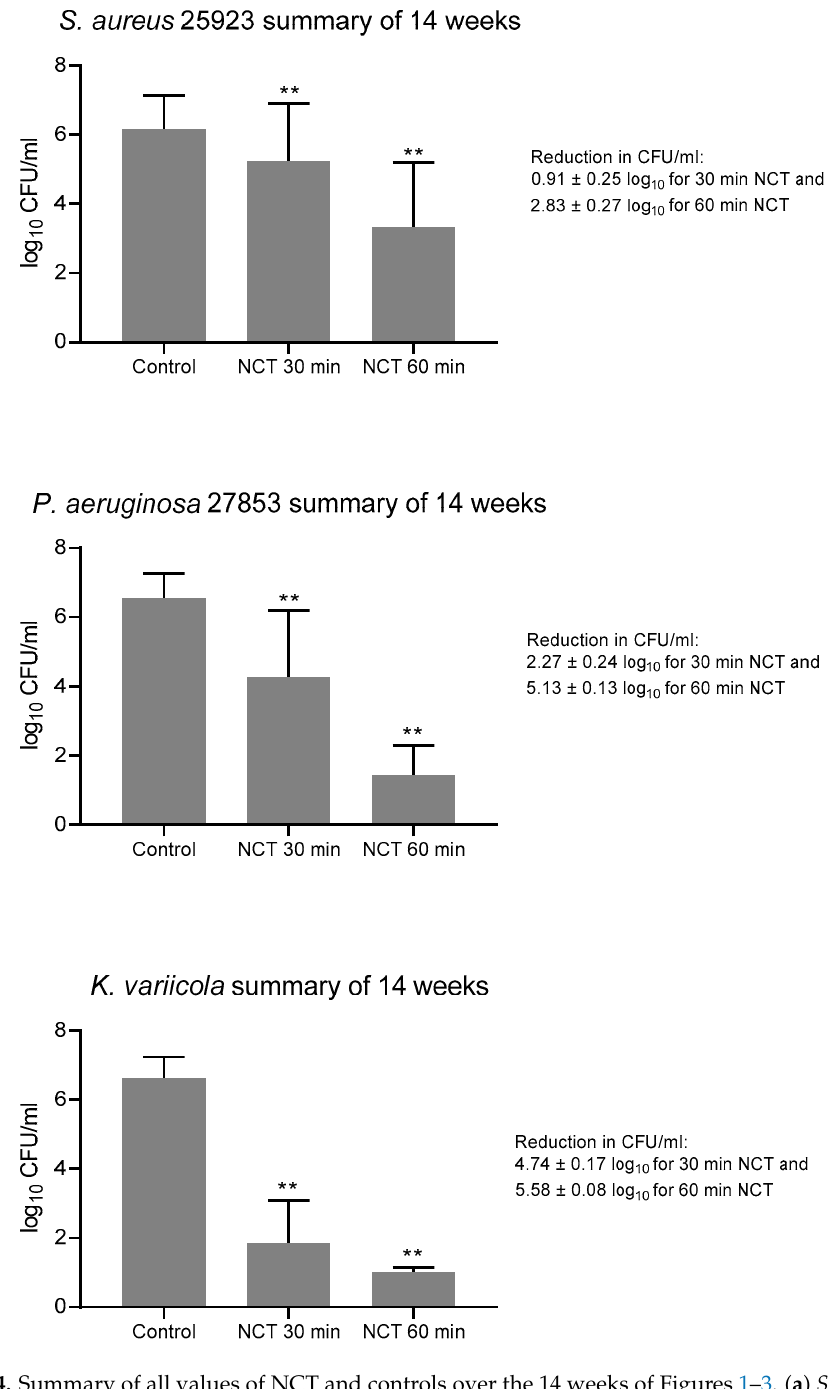
Figure 4. Summary of all values of NCT and controls over the 14 weeks of Figures 1–3. ( a ) S. aureus , n = 62; ( b ) P. aeruginosa , n = 73–74; ( c ) K. variicola , n = 64–65. Mean values ± SD. ** p < 0.01 for controls versus NCT and for 30 min versus 60 min incubation time in all panels.